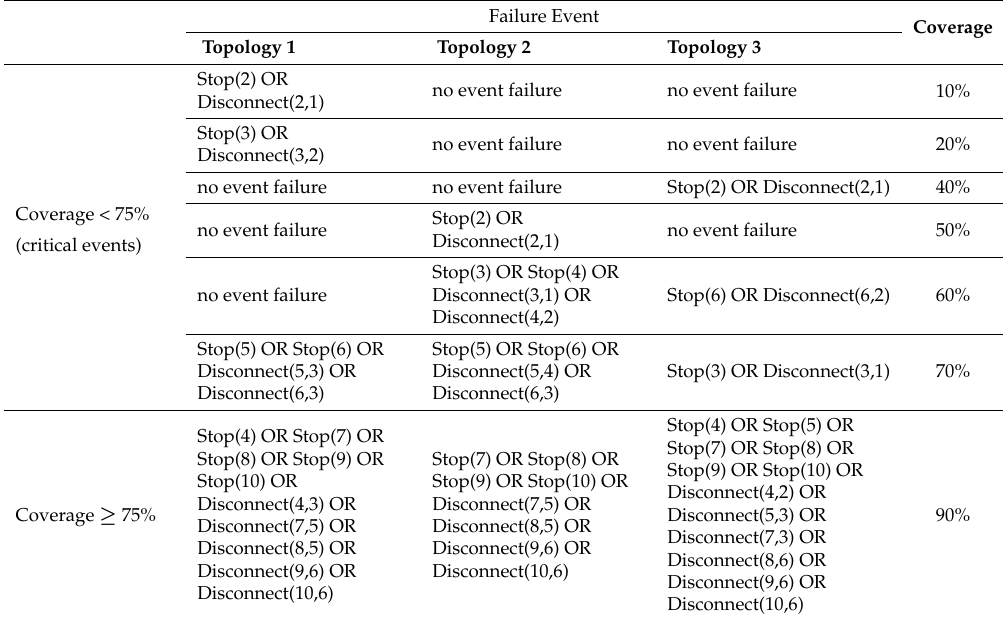
Table 5. Classification of failure events for MEDiSN (Topology 1, 2 and 3).